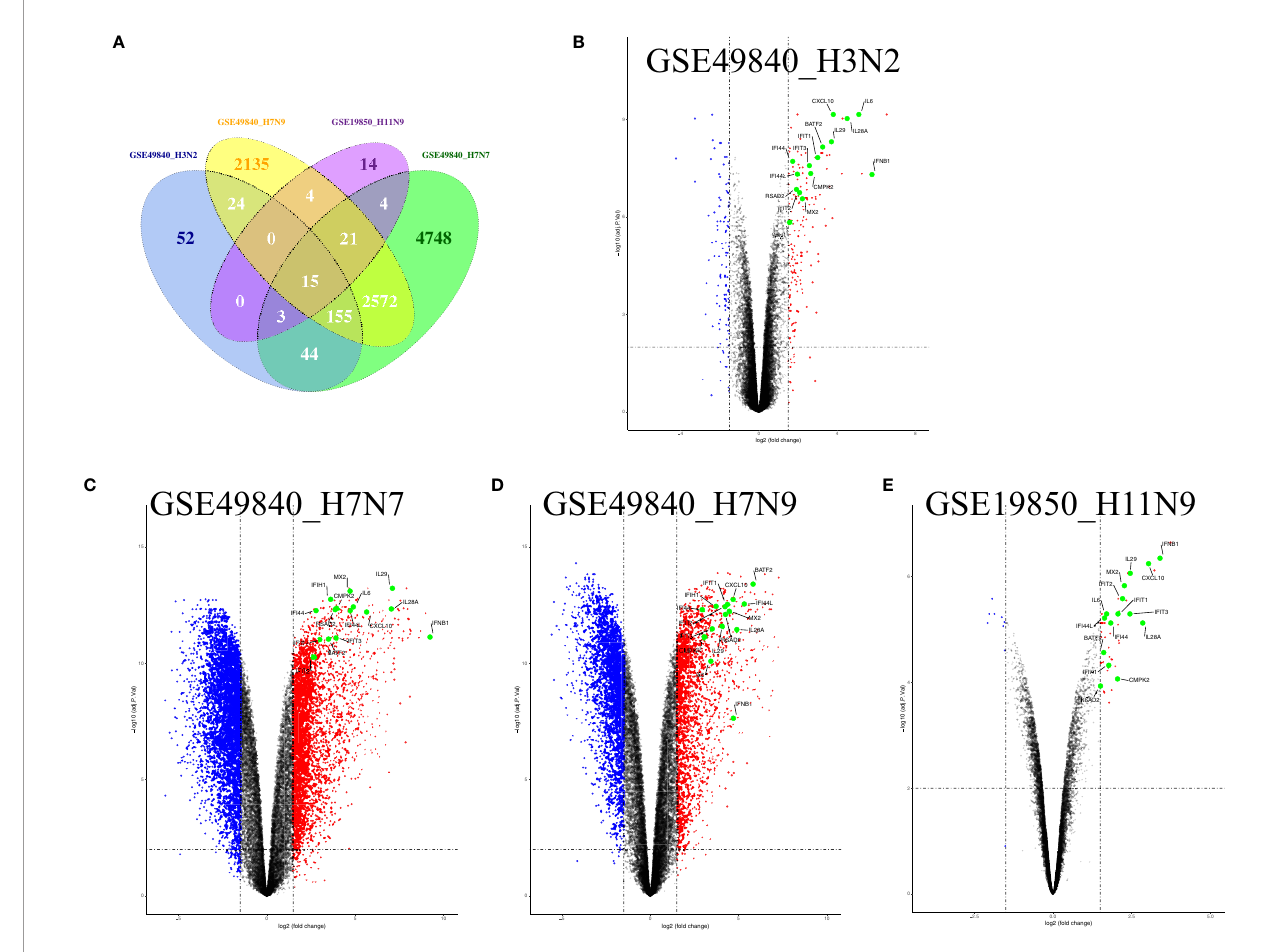
FIGURE 4 | Fifteen overlap genes were identi fi ed to signi fi cantly upregulate in H3N2, H7N7, H7N9, and H11N9-infected Calu-3 cells. (A) Venn diagram of the overlap genes; (B) Volcano plots of the overlaps between mock and H3N2-infected cells; blue and red dots indicate signi fi cantly downregulated and upregulated genes, respectively. (C) Volcano plots of the overlaps between mock and H7N7-infected cells; blue and red dots indicate signi fi cantly downregulated and upregulated genes, respectively. (D) Volcano plots of the overlaps between mock and H7N9-infected cells; blue and red dots indicate signi fi cantly downregulated and upregulated genes, respectively. (E) Volcano plots of the overlaps between mock and H11N9-infected cells. The vertical dashed lines correspond to 1.5-fold up and down expression and the horizontal dashed line represents a p -value of 0.01. Blue and red dots indicate signi fi cantly downregulated and upregulated genes, respectively. The 15 overlapped genes identi fi ed in different IAV subtype infection are exhibited in the Volcano